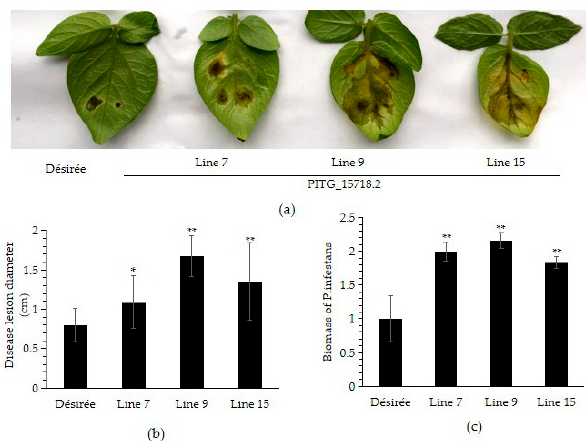
Figure 3. Constitutive expression of PITG_15718.2 enhanced susceptibility to P. infestans in potato. ( a ) Three PITG_15718.2 -expressing lines were challenged with P. infestans HLJ. Images were photographed at four days post-inoculation (dpi). Désirée was used as control; ( b ) the lesion size was significantly enhanced on both transgenic potato lines compared to the control. The disease lesion diameter was calculated from at least 15 leaves using the average of the longest and shortest diameters on each leaf. * indicates significant ( t test, p < 0.05) differences, ** indicates extremely significant ( t test, p < 0.01) differences; ( c ) determination of P. infestans biomass by quantitative real-time PCR. P. infestans –specific primers referred the PI-O8 element were used for PCR with the mixed-DNA template that was isolated from infected leaves (containing the DNA of P. infestans and S. tuberosum ). The host gene ( StEF ) was used to normalize the results. ** indicates extremely significant ( t test, p < 0.01) differences. The experiment was repeated three times with similar